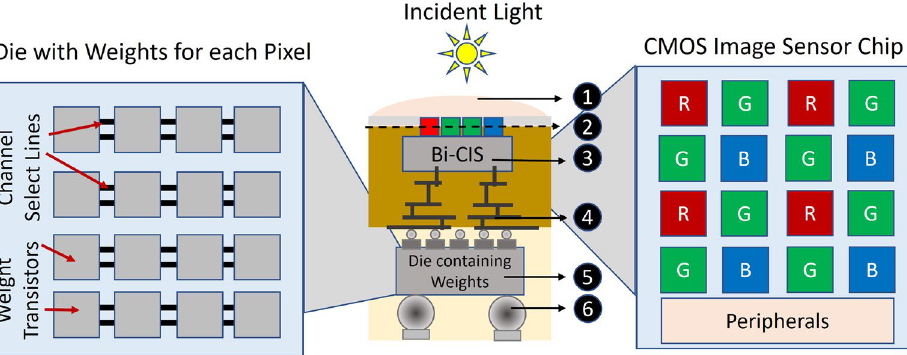
Figure 5. Representative illustration of heterogeneously integrated system featuring P 2 M paradigm, built on backside illuminated CMOS image sensor (Bi-CIS). 1 CMOS Image Sensor (Bi-CIS), 4 bumps for input/output bus